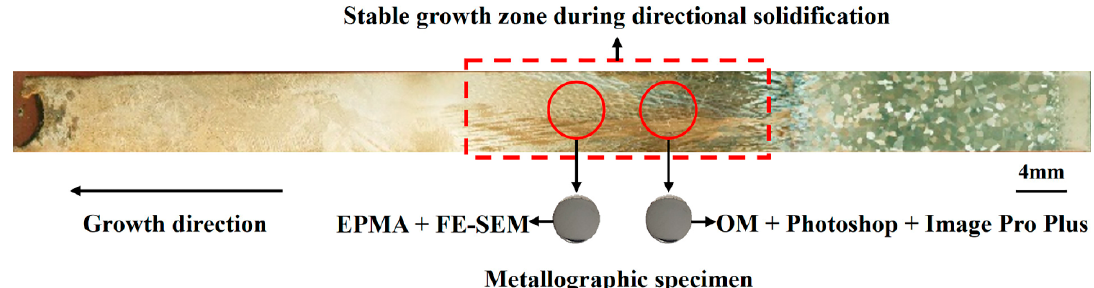
Figure 2. Schematic of the extracted metallographic sample.